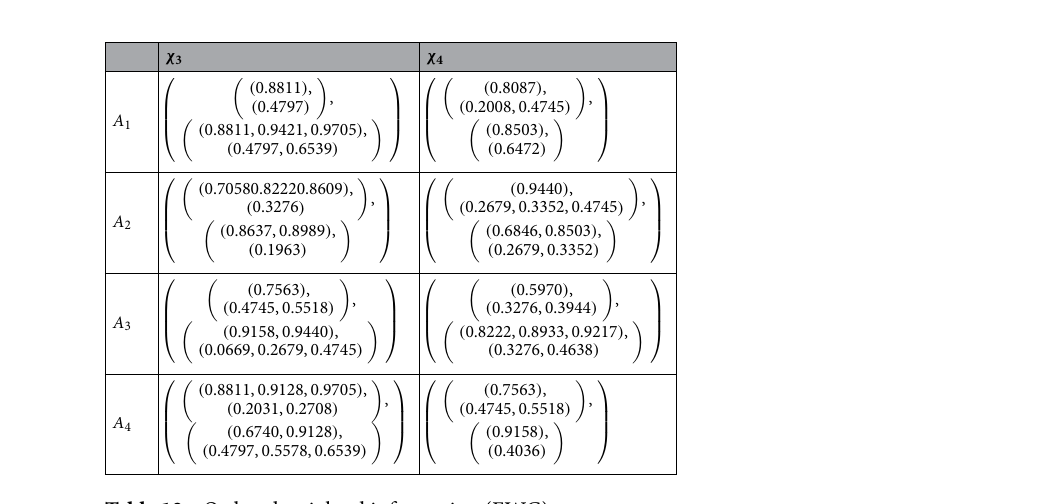
Table 12. Ordered weighted information (EWG).